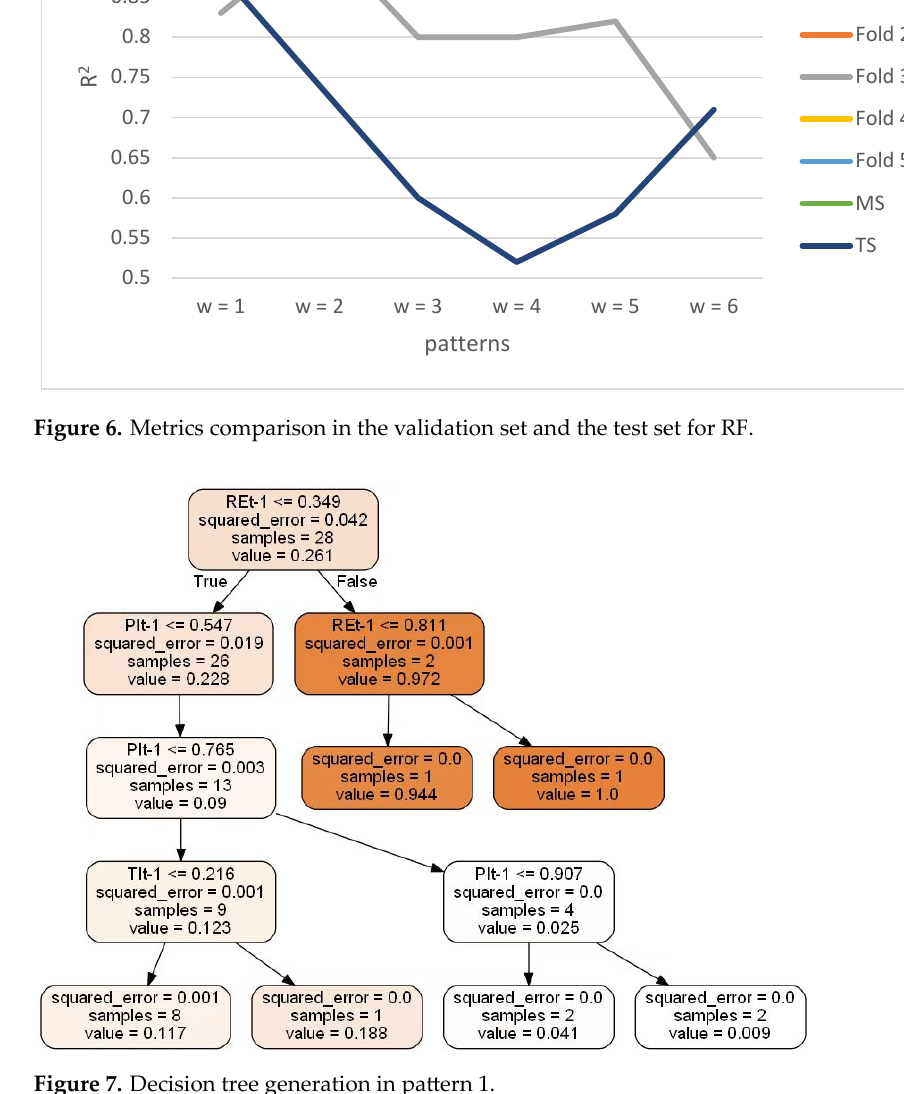
Figure 6. Metrics comparison in the validation set and the test set for RF.